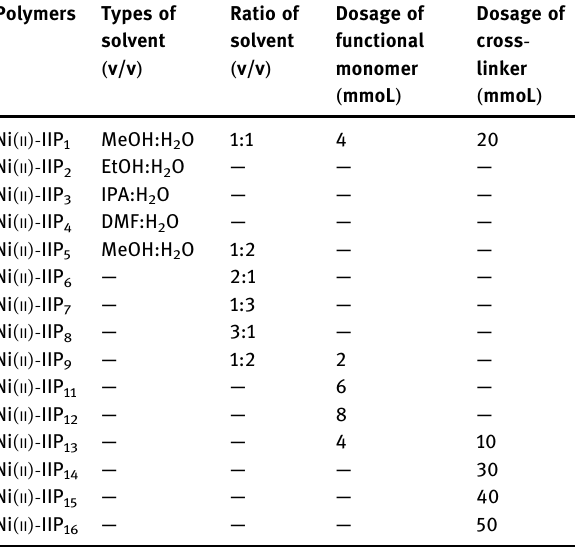
Table 1: Preparation of Ni ( II )- IIP and